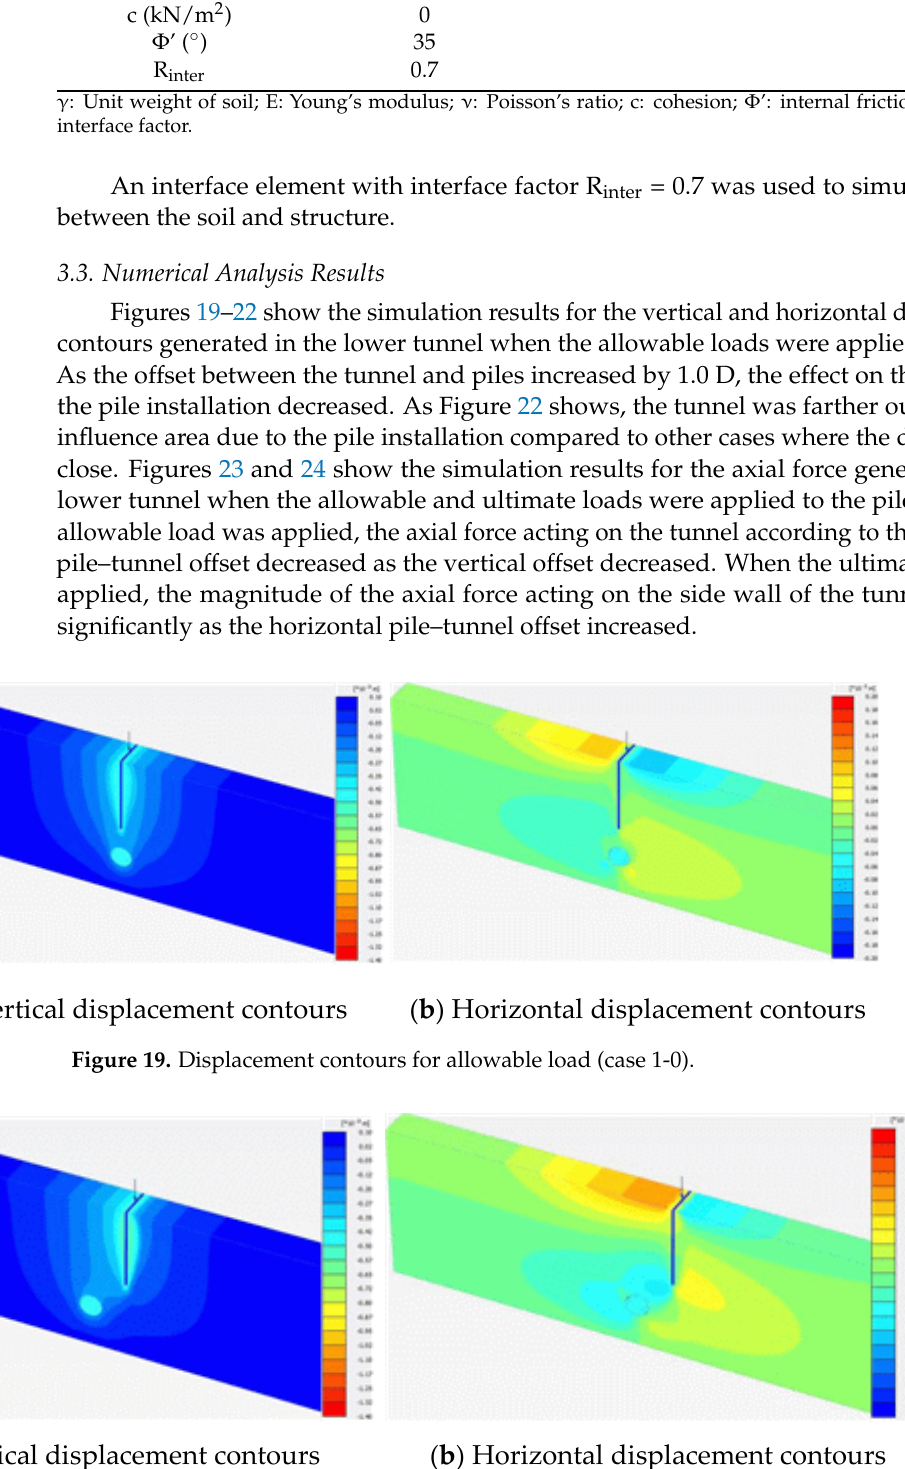
Table 5. Material properties for numerical analysis.